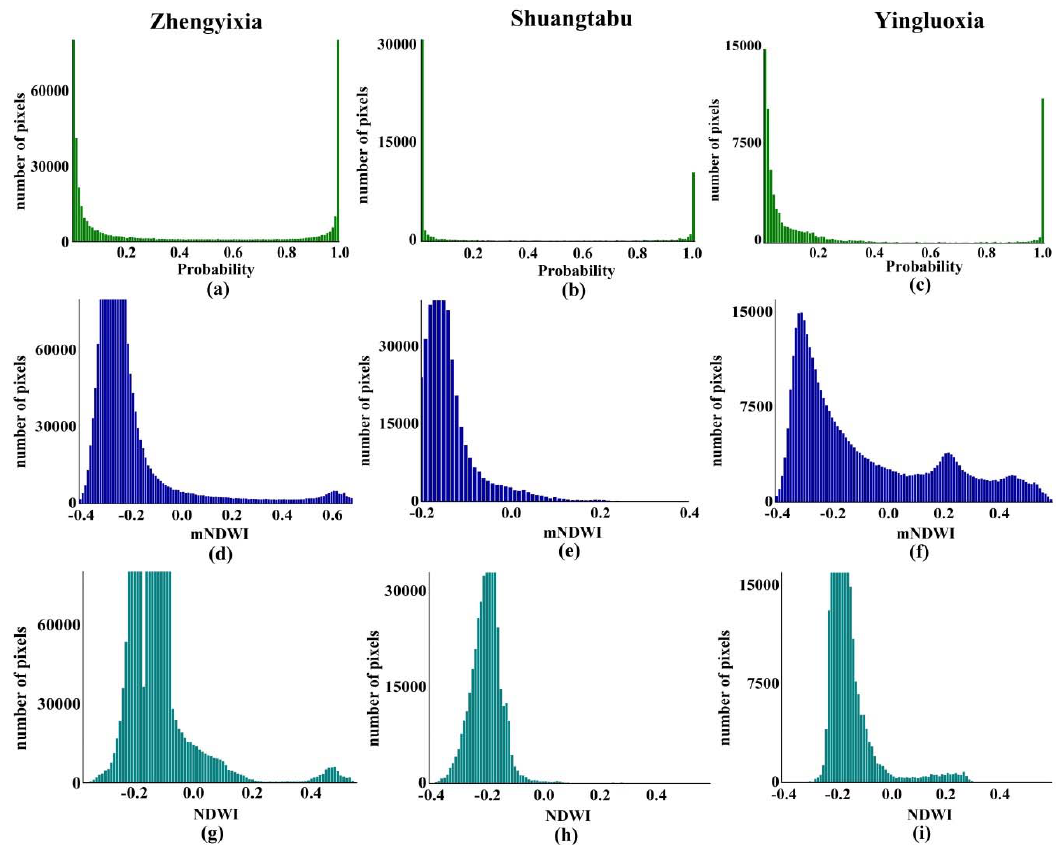
Figure 8. Histograms of posterior probability, modified Normalized Difference Water Index (mNDWI), and NDWI for the Zhengyixia, Shuangtabu, and Yingluoxia reaches.